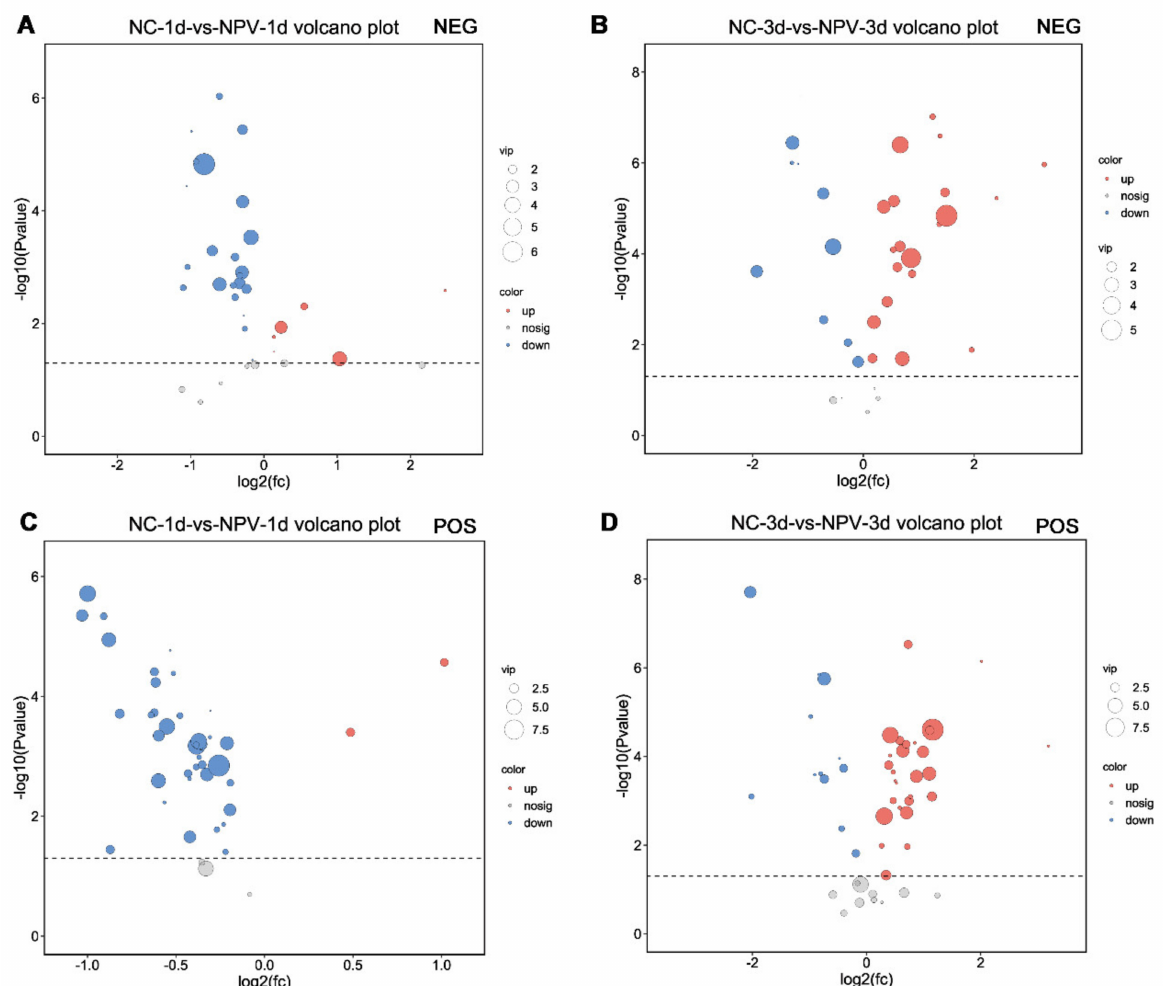
Figure 3. Volcano plots of metabolites in the hemolymph of BmNPV-infected and PBS-injected silkworms. ( A , B ) were derived from the negative mode (NEG) models at 1 d and 3 d, respectively. ( C , D ) were derived from the positive mode (POS) models at 1 d and 3 d, respectively. Each point in the volcanic map represents a metabolite. Red: Up-regulated metabolites. Blue: Down-regulated metabolites. Gray: Not significant. fc: Fold